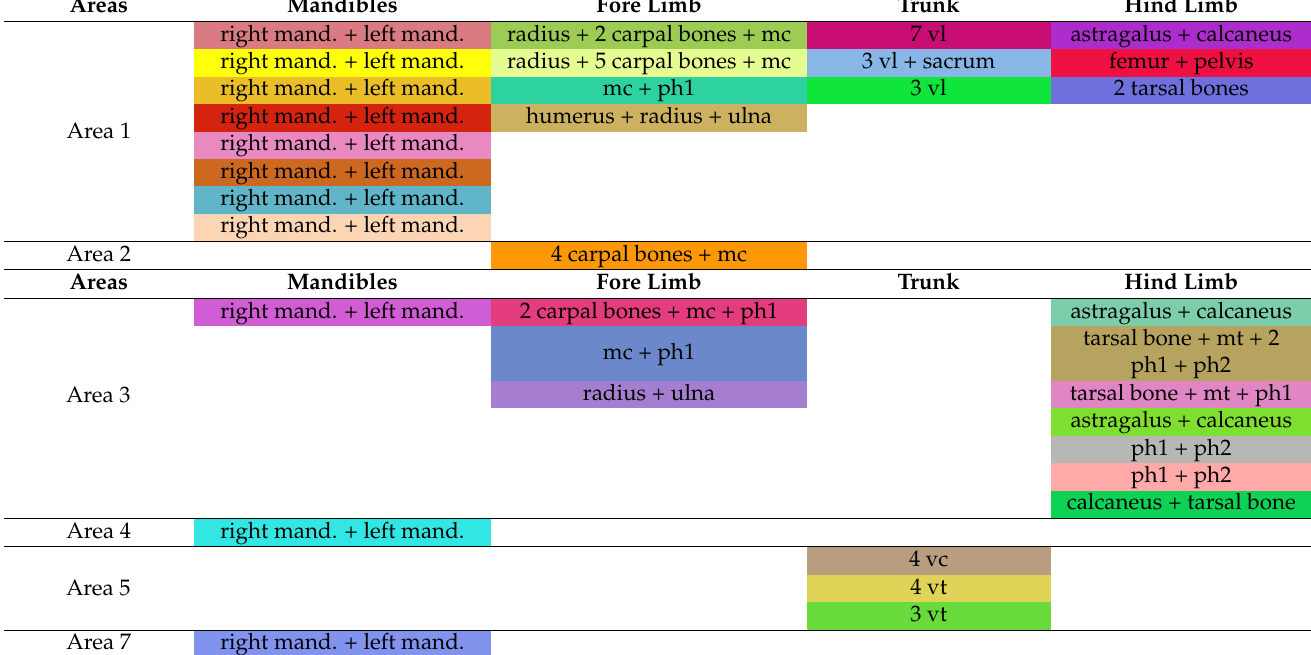
Table 7. Connections between cattle remains documented in the different areas of the Vilauba pit. Figure 13 and Figure 14 for the colour-coding. Areas Mandibles Fore Limb Trunk Hind Limb right mand. + left mand. radius + 2 carpal bones + mc 7 vl astragalus + calcaneus right mand. + left mand. radius + 5 carpal bones + mc 3 vl + sacrum femur + pelvis right mand. + left mand. mc + ph1 3 vl 2 tarsal bones Area 1